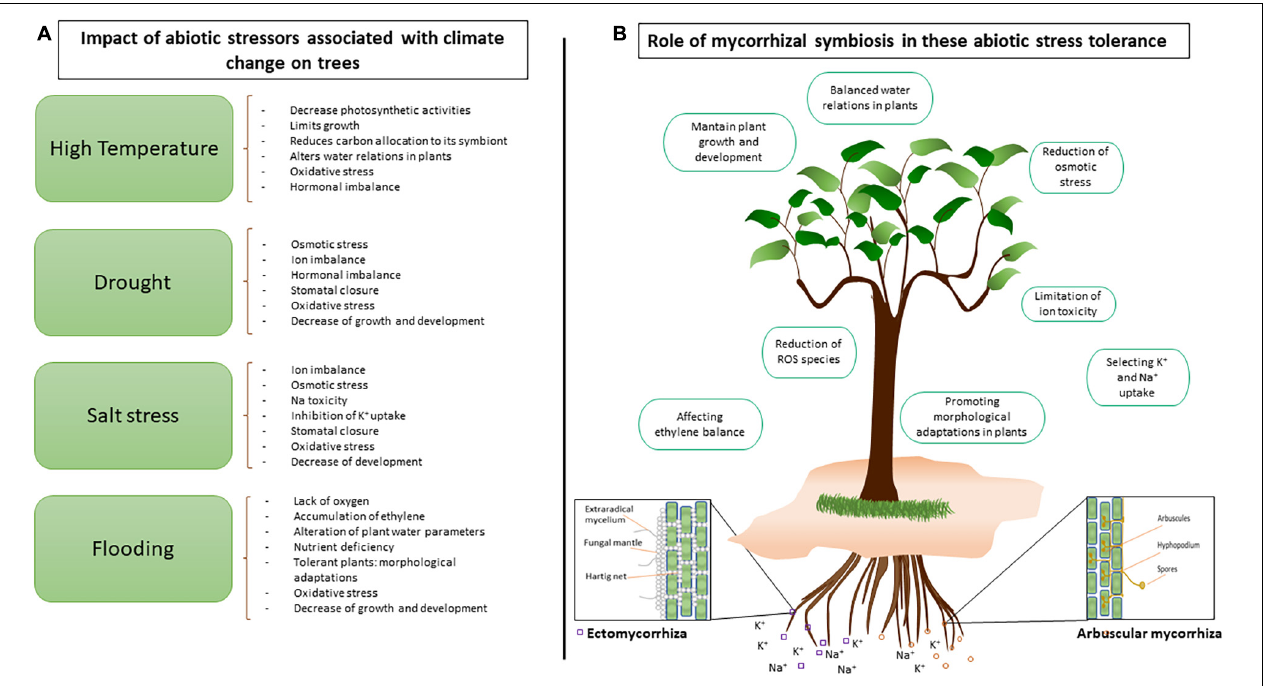
FIGURE 1 | Mycorrhizal fungi alleviate climate change-linked abiotic stress affecting tree growth in temperate and boreal forests. (A) Trees are affected by increasing abiotic stress linked to climate change such as high temperatures, drought, salt stress, and flooding. (B) However, tree-associated mycorrhizal (ECM, ectomycorrhizal and AM, arbuscular mycorrhizal) fungi improve plant water and mineral nutrition (among them potassium K + ) and help to adapt to stressful environmental conditions (among them elevated sodium Na + in saline conditions).